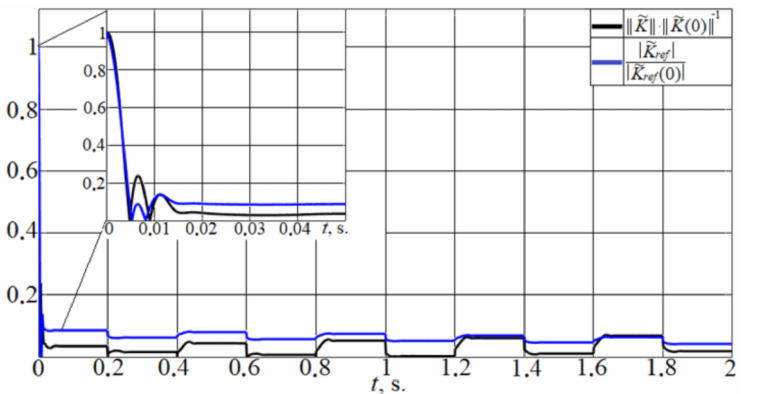
(cid:12)(cid:12) (cid:12) (cid:12) (cid:12) (cid:12) (cid:12) (cid:12)(cid:101) K − 1 (cid:12) (cid:12) (cid:12)(cid:101) K ( 0 ) ref (cid:12) ref